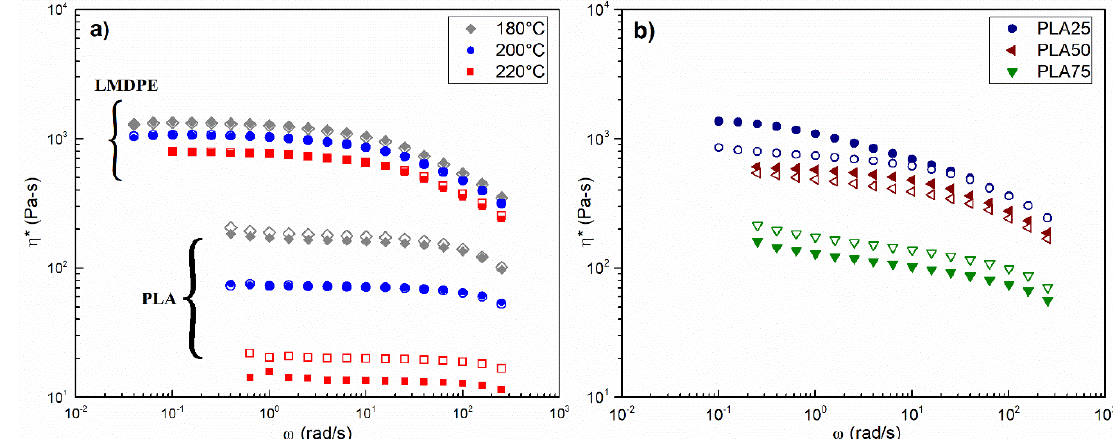
Figure 1. Complex viscosity as a function of frequency for ( a ) neat PLA and LMDPE at different temperatures, ( b ) blends at 200 °C. Open symbols are for dry-blending (DB) and closed symbols for melt-blending (MB) mixing strategy. In neat materials, DB and MB are completely superimposed at several frequency values.